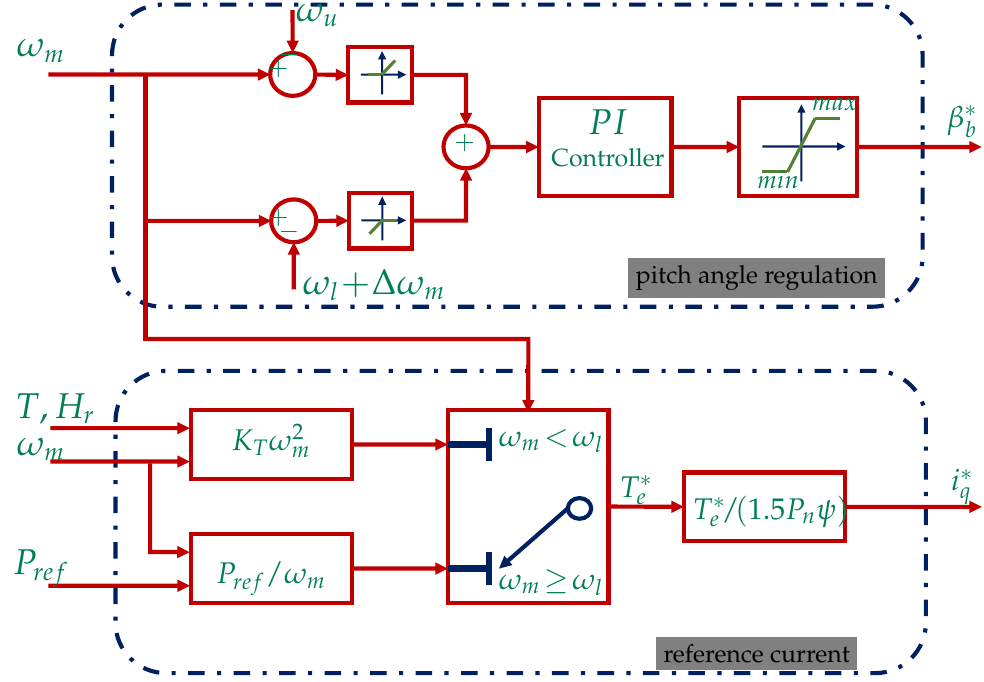
Figure 18. Active power control for reference power tracking with pitch angle